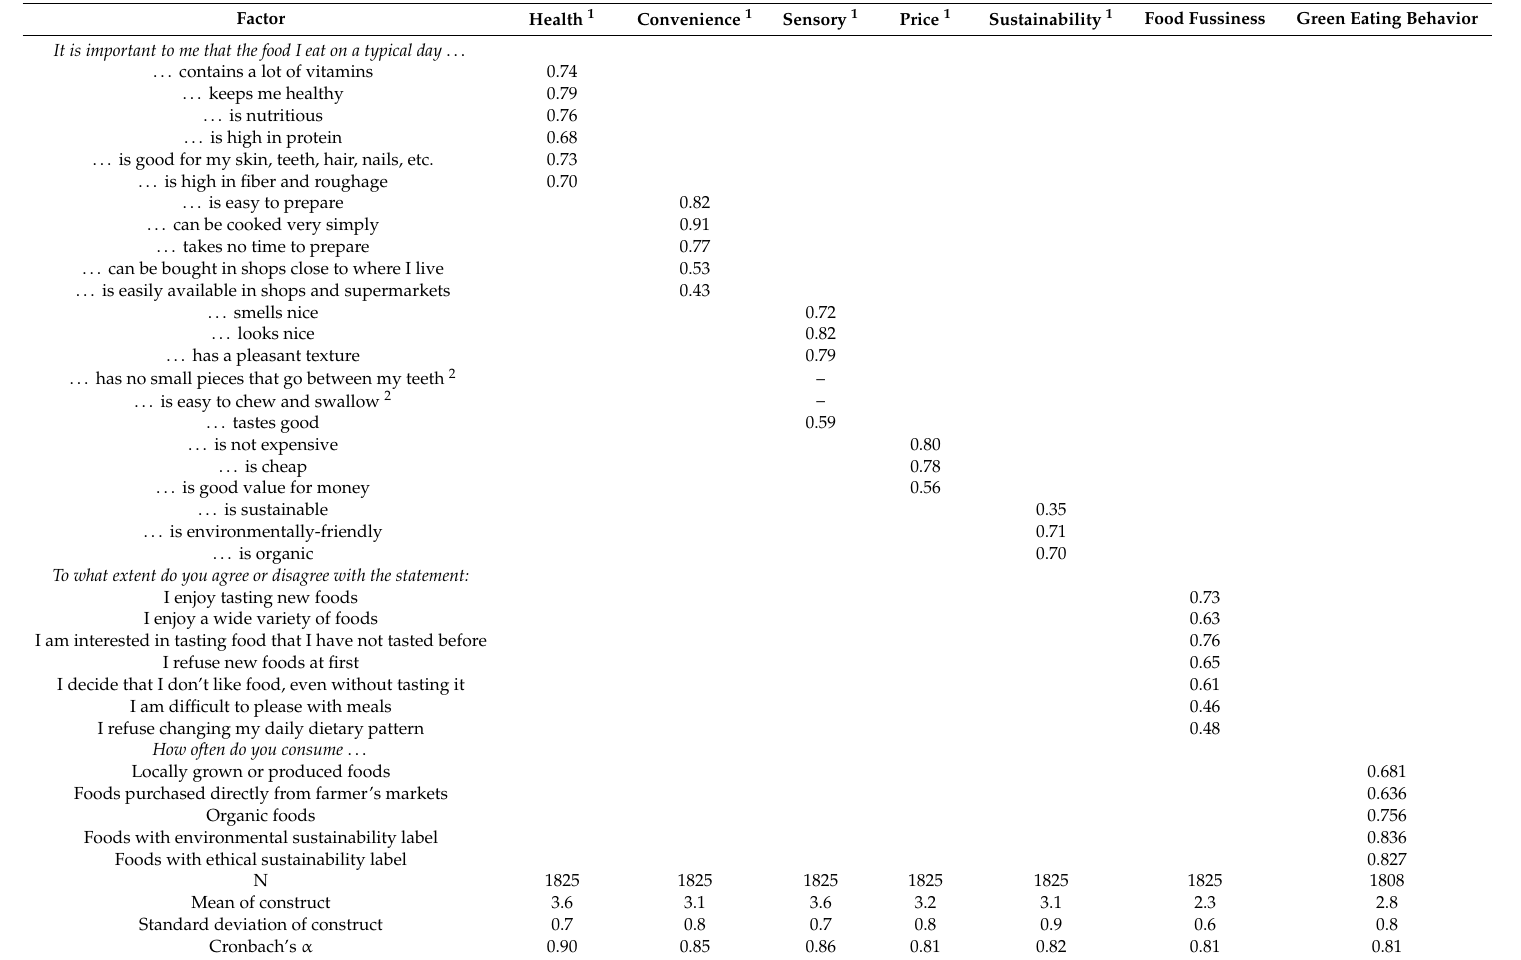
Table A2. Factor loadings from principal axis factor analysis in of 1825 adults aged 65 years and older from five EU countries. Factor Health 1 Sensory 1 Price